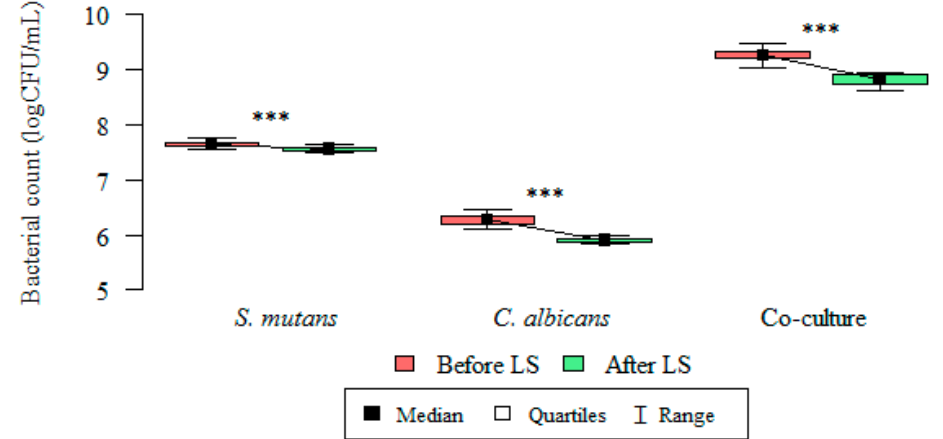
Figure 6. S. mutans , C. albicans , and oral streptococci/yeast biofilm formation: changes in microorganism count (logCFU/mL), before and after administration of Lactobacillus salivarius (HM6 Paradens) after 24 h. Wilcoxon’s test was used for dependent (repeated) measurements (paired Wilcoxon’s test; p < 0.05). Data are represented as median ± 1–3 quartiles for the three experiments. *** Indicates statistically significant difference compared to untreated biofilms ( p < 0.001). Nutrients 2017 , 9 , 1242